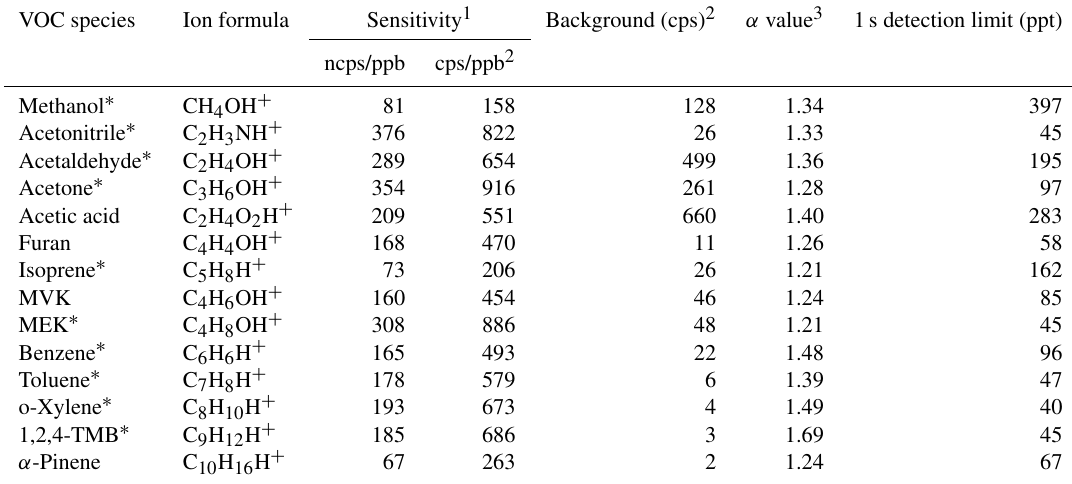
Table 1. Sensitivities and detection limits of H 3 O + ToF-CIMS for various VOC species during the SONGNEX campaign. VOC species Ion formula Sensitivity 1 Background (cps) 2